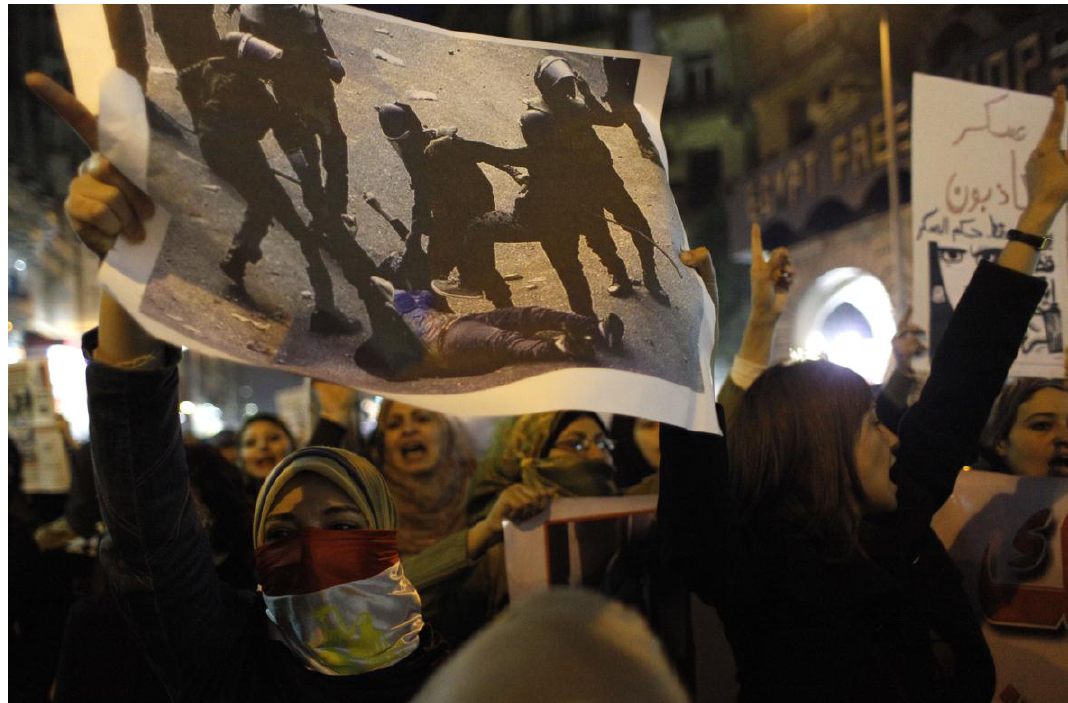
Figure 3. Egyptian women angered by the recent violence used against them in clashes between army soldiers and protesters, one carrying a poster with a picture of a woman that assaulted by soldiers, chant anti-military slogans during rally that ended in Tahrir Square, Cairo, Egypt Tuesday, 20 December 2011. Nasser/Nasser, Associated Press. Used with permission.